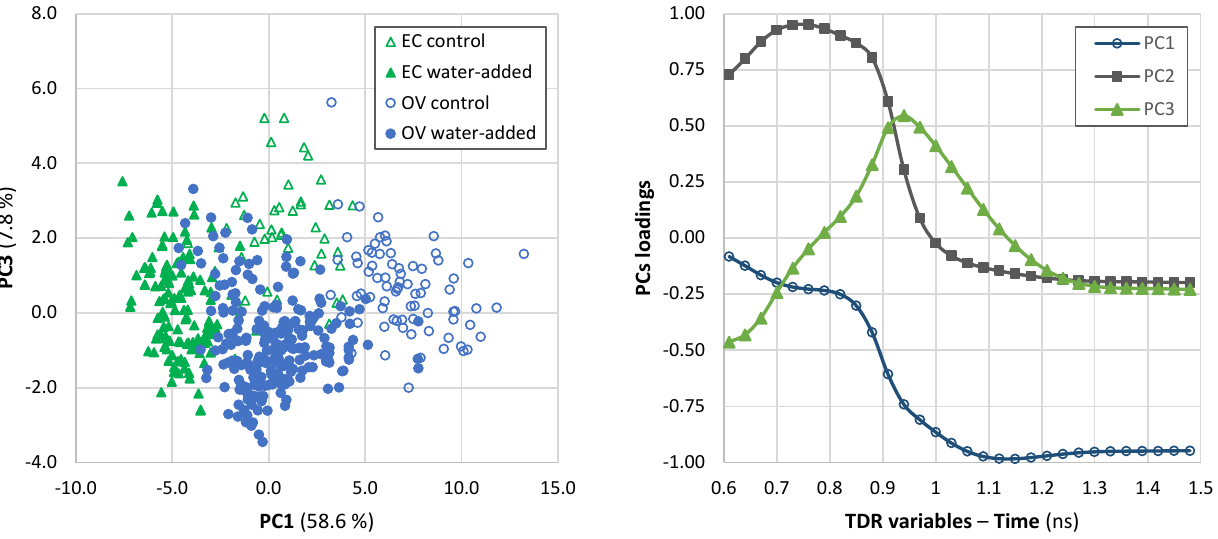
Figure 5. Plot of principal components analysis of TDR data of Octopus vulgaris (OV) and Eledone cirrhosa (EC) samples and loadings of PC1, PC2, and PC3. Immersion time of water-added treatments varied from 0.5 to 36 h. TDR data between 0.6 and 1.5 ns were included in the multivariate analysis. PC1, PC2, and PC3 explained, respectively, 58.6%, 28.8%, and 7.8% of the variation of original TDR variables.